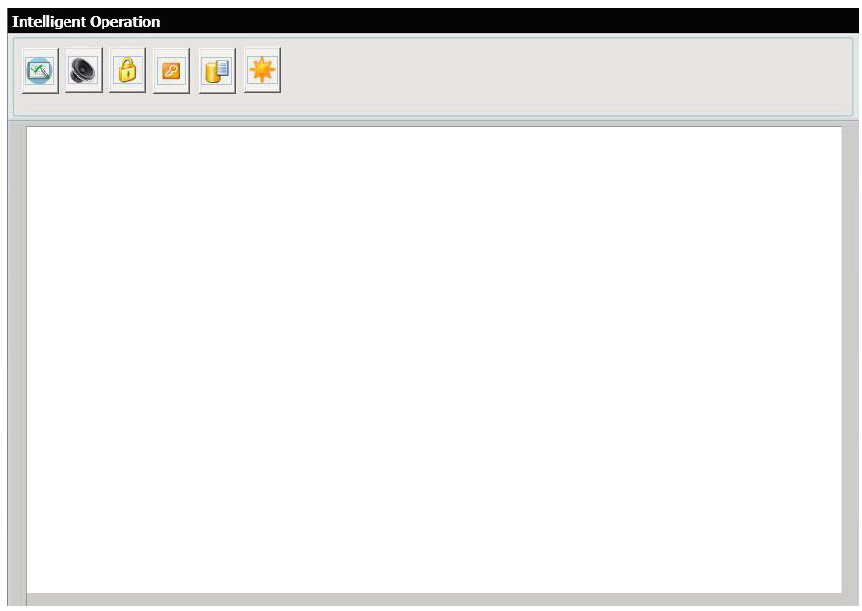
Figure 7. Intelligent operation view containing six intelligent